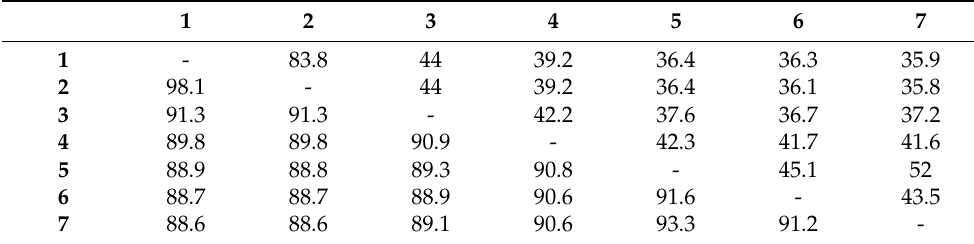
Table 2. Average nucleotide identity based on BLAST (ANIb) and pairwise in silico DNA-DNA hybridization ( is DDH) using GGDC formula 2 values for the Bacillus sp. B10 isolate and the most closely related members of the genus Bacillus . The numbers below the diagonal are ANI values predicted between pairs of genomes. The numbers above the diagonal are is DDH values between